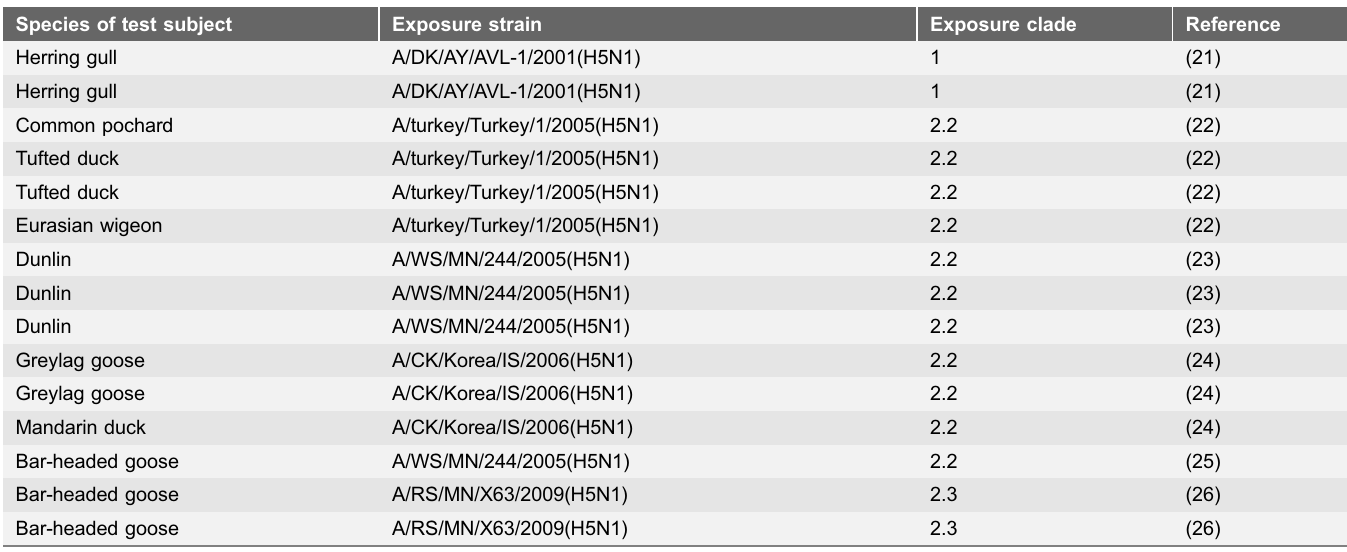
Table 2. Positive control